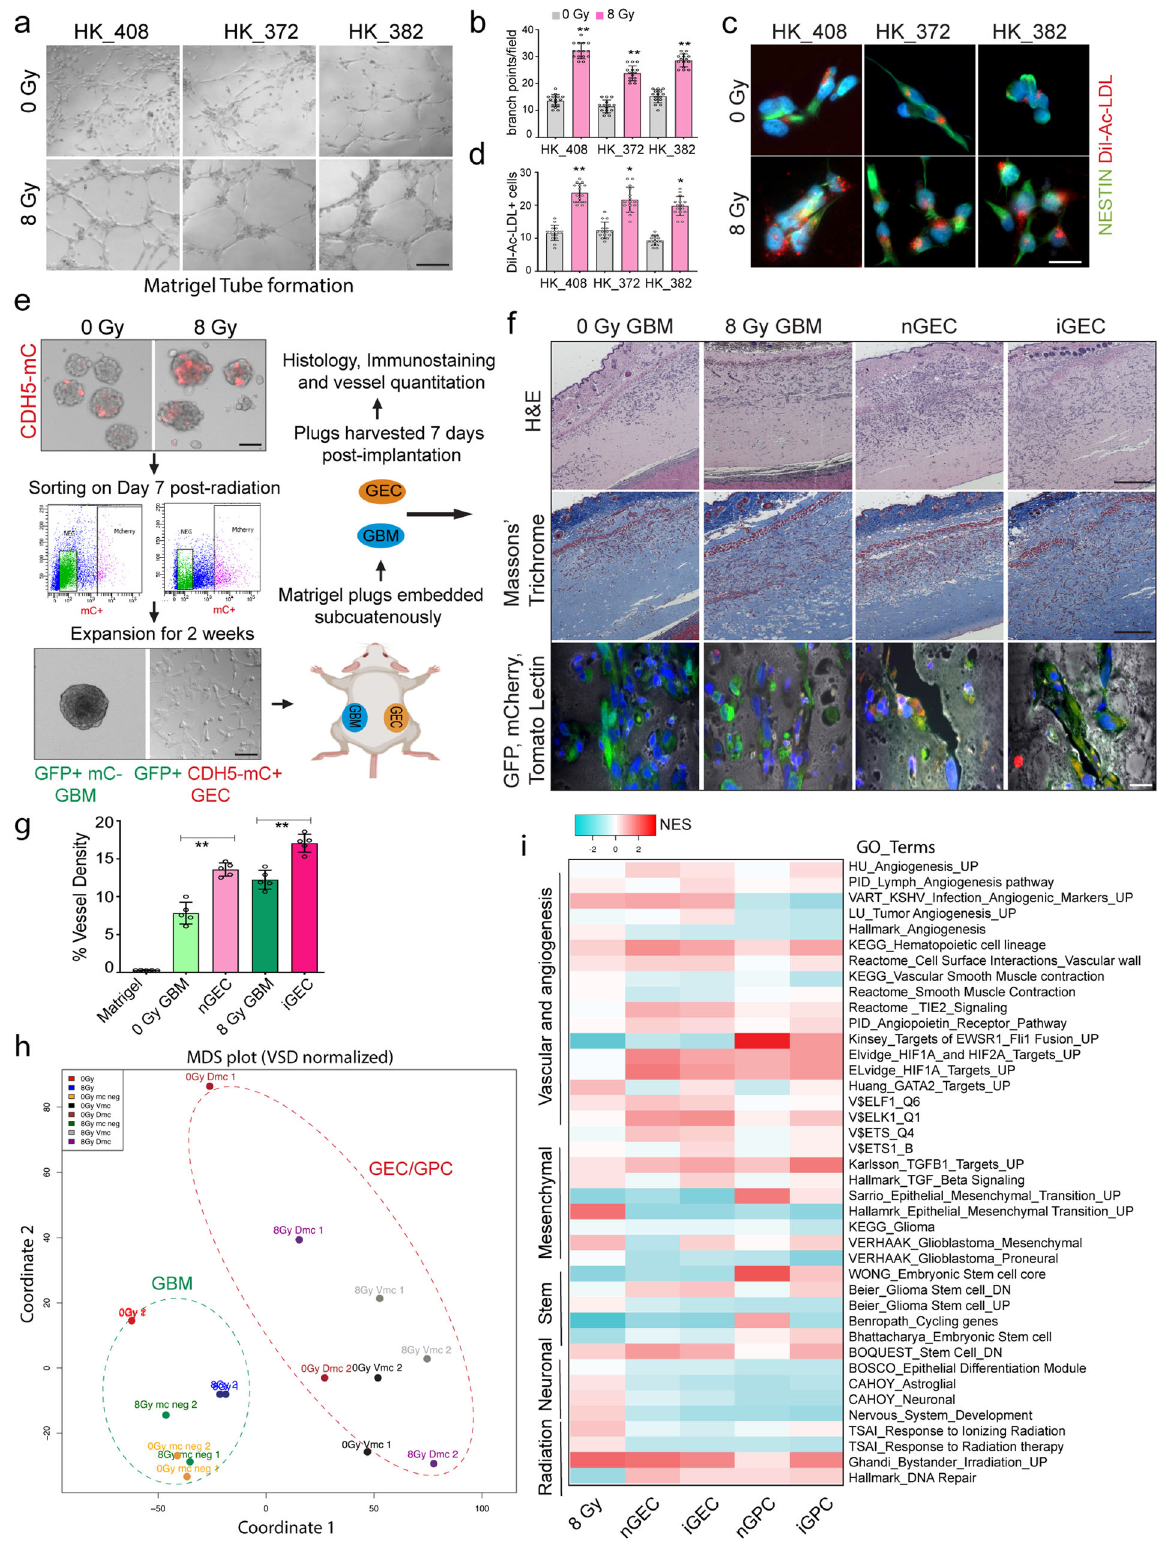
Fig.3|iGECdisplaytypicalcharacteristicsofnormalvascularendothelialcells. a – d TubularnetworkformationonmatrigelandimmunostainingofNESTINandDi- Ac-LDL in control and radiated glioma cells. Scale bars, 100 μ m and 50 μ m. Quantitation of branch points and number of Di-Ac-LDL+cells per fi eld in each group.Errorbarsrepresentmean±SD, N =3biologicalreplicates,*and**indicates p <0.05and p <0.005,unpairedtwo-tailedt-test. e Schematicoutlinesthematrigel